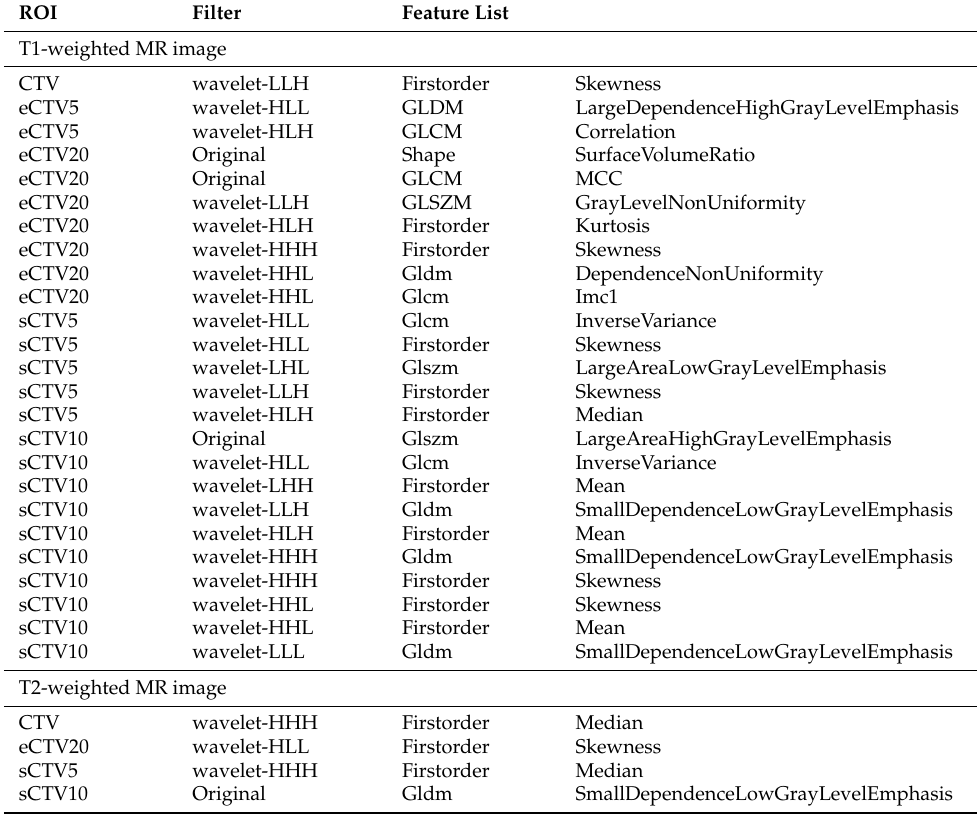
Figure 4. Radiomics features were selected using the LASSO regression. ( a ) Tuning penalization parameter (λ) and minimum criterion in the LASSO model. The binomial deviance was plotted against log(λ). ( b ) LASSO coefficient profiles of the 4185 radiomics features. The green line showed the optimal lambda in the LASSO analysis with the least partial likelihood of deviance. Table 4. Selected the features by LASSO Cox regression.